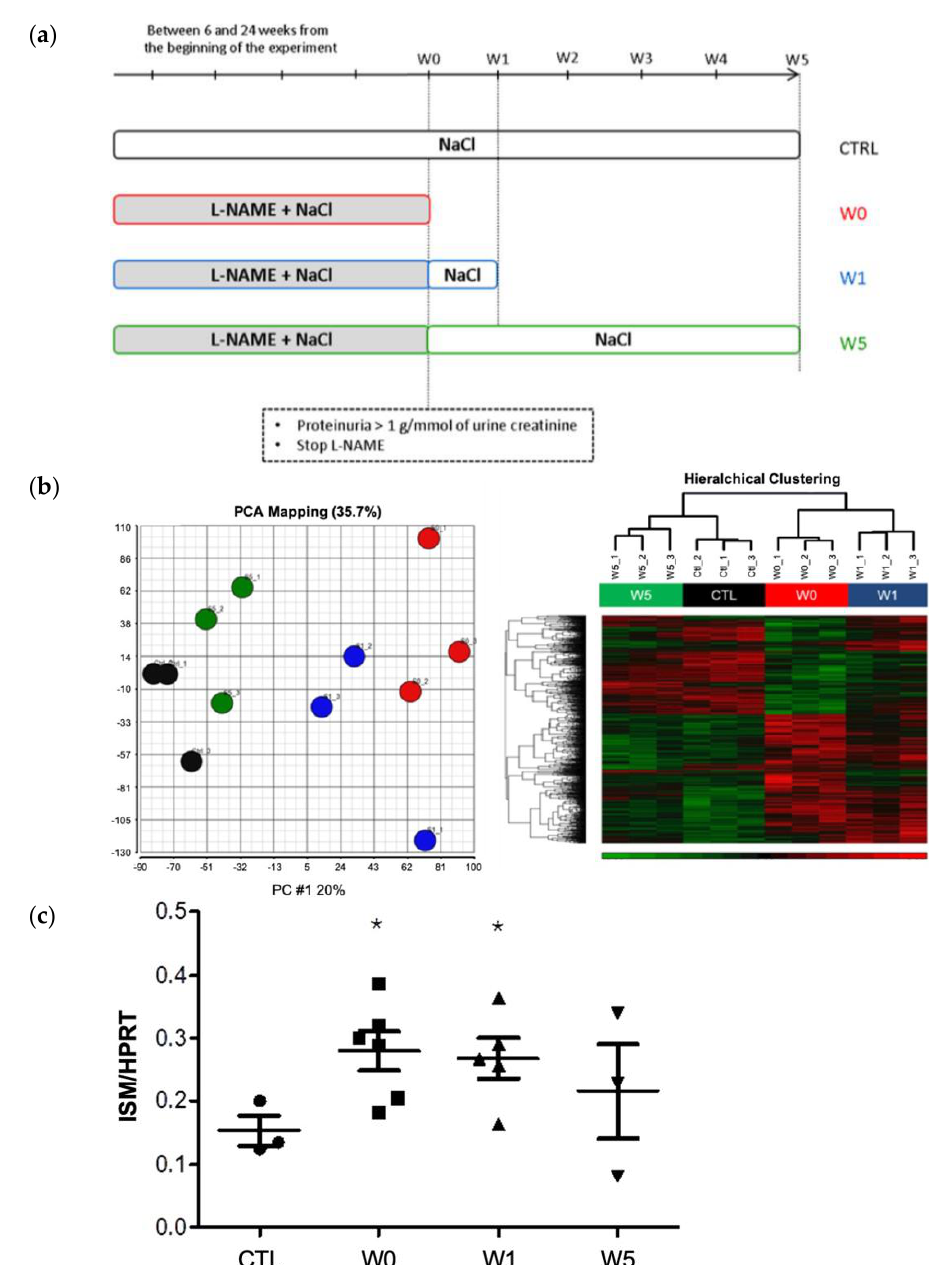
Figure 2. ISM1 gene expression in L-NAME model. ( a ) Experimental protocol of L-NAME model. When urinary protein excretion ratio was over 1 g/mmol of creatinine, after 6 to 24 weeks, NG-nitro-L-arginine methyl ester (L-NAME) was removed. ( b ) Left panel. Segregation of transcriptomic data of each animal by principal component analysis: Each animal is represented by a circle in the corresponding group (CTL in black, W0 in red, W1 in blue, and W5 in green). Right panel. Hierarchical grouping of transcriptomic data from each animal: Each line corresponds to a gene and each column to an animal. The red color indicates an overexpression and the green color an under expression. This representation clearly shows a variation of gene expression from one group to another. ( c ) ISM1 is overexpressed in glomeruli of the L-NAME rat model. mRNA expression of ISM1 from kidney of CTL rats, L-NAME treated rats (W0), 1 week L-NAME removal rats (W1), and 5 weeks L-NAME removal rats (W5). mRNA of ISM1 is significantly overexpressed in the kidney of W0 and W1 L-NAME rats (* p < 0.05 vs control group).